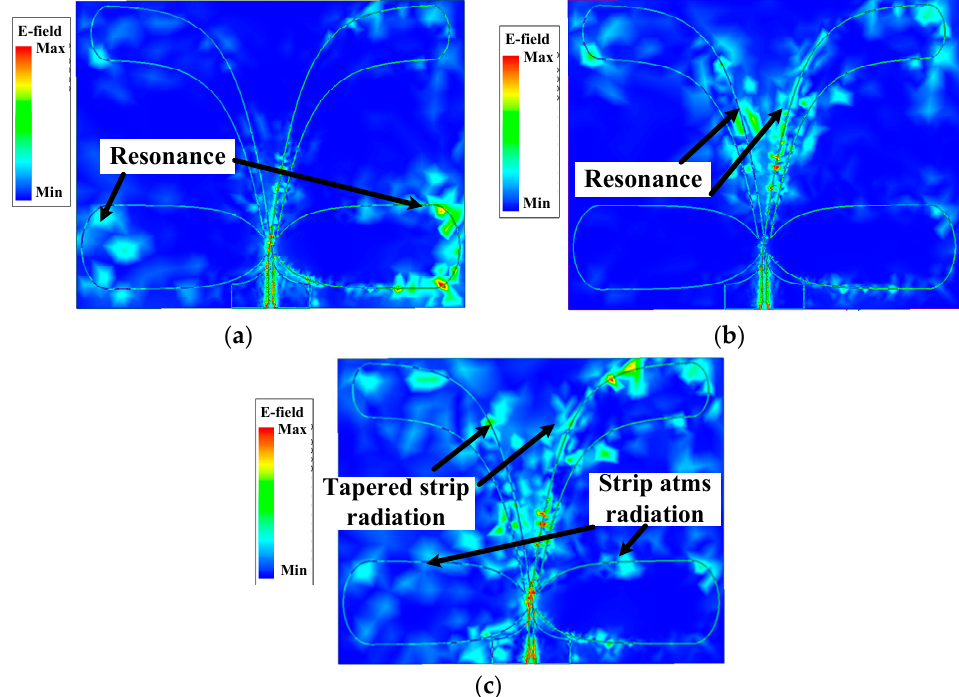
Figure 6. Electric field distribution above the top layer of the proposed antenna structure at ( a ) 0.8 GHz, ( b ) 1.6 GHz, and ( c ) 4 GHz.